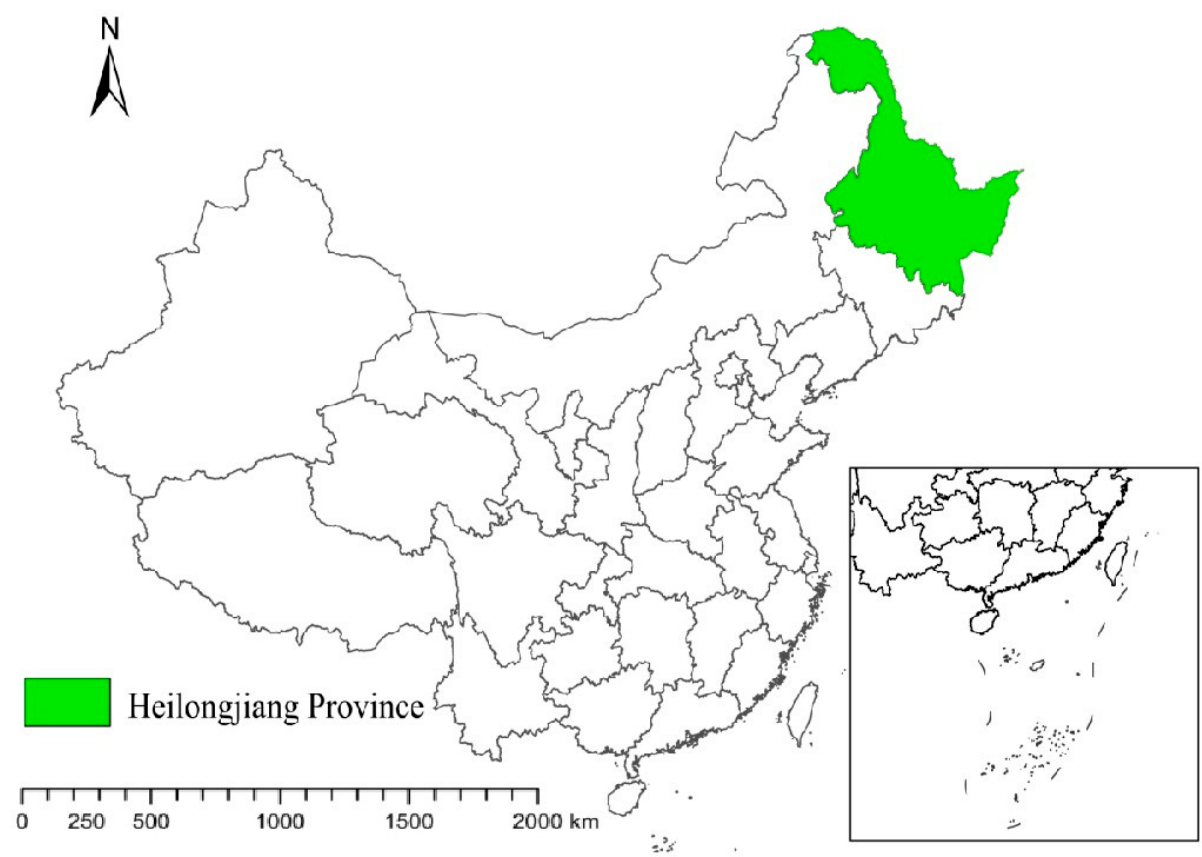
Figure 2. Location of the study area. Source: Drawn by the authors.